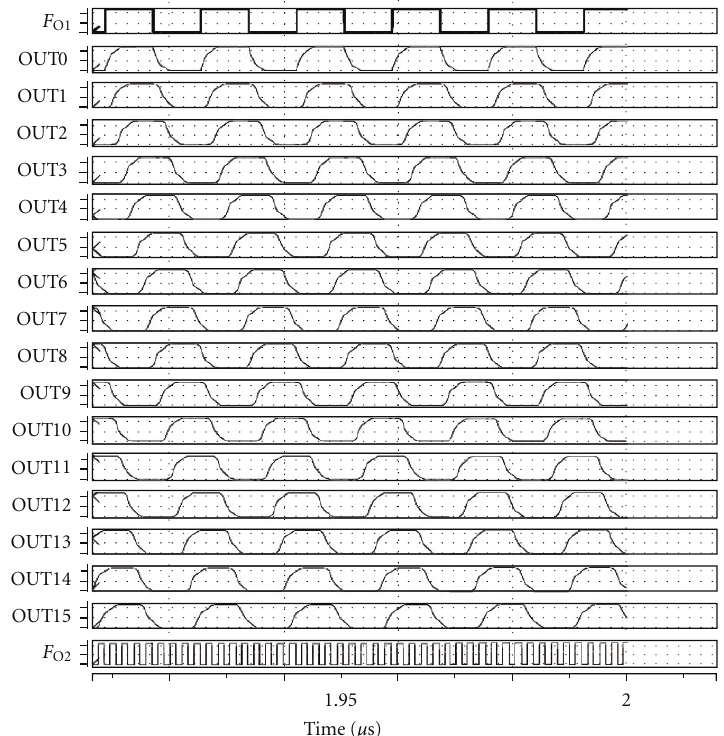
Figure 28: Postlayout simulation result of VCDL output signals from DLL2 settling operation. The simulation condition is tt/1.2V/25 ◦